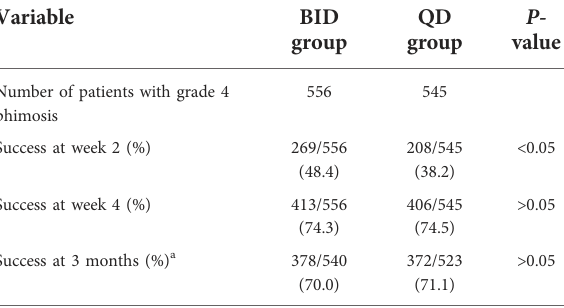
TABLE 2 Comparison in success outcomes of patients with grade 4 phimosis between the BID group and QD group.